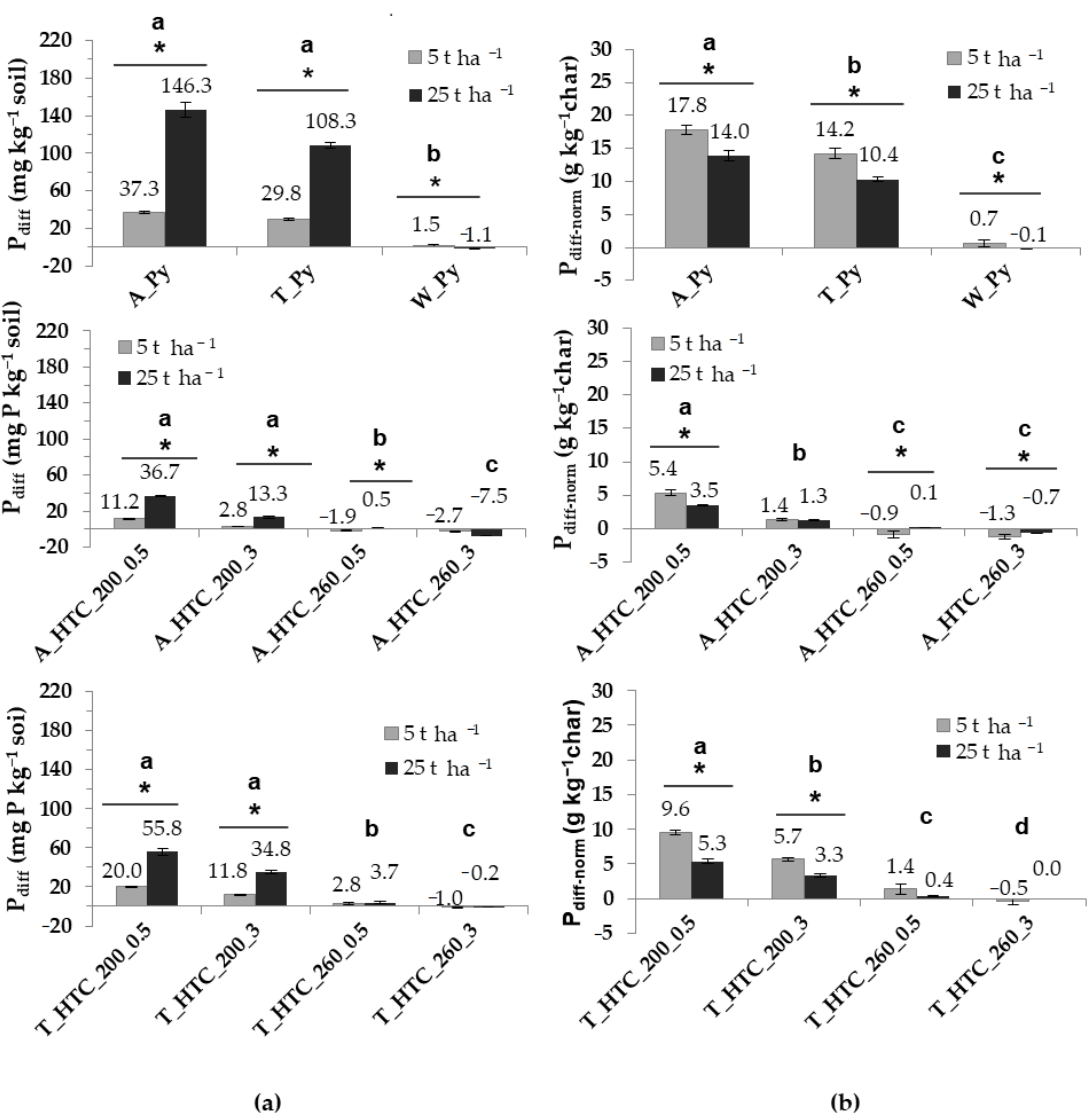
Figure 3. ( a ) Difference in Olsen-P (P diff ) from the Olsen-P in the chars before starting and at the end of the experiment; ( b ) phosphorus release normalized to kg of added char (P diff-norm ). The above-line asterisks indicate significant differences between doses. The letters show significant differences between treatments. The hydrochars were produced from primary (A) and secondary sludge (T) at 200 °C and 260 °C for 0.5 h and 3 h (A_HTC 200_0.5/3, A_HTC 260_0.5/3; S_HTC 200_0.5/3, T_HTC 260_0.5/3). The pyrochars A_Py and T_Py were obtained from primary and secondary sludge and W_Py from green waste. Error bars represent the standard deviation of the mean ( n = 4)